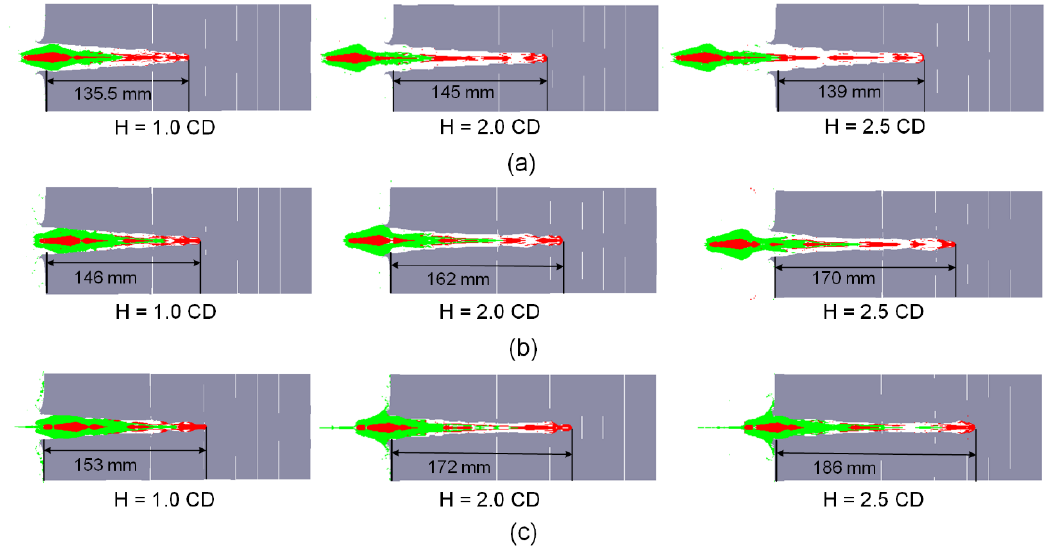
Figure 13. Numerical simulation results of the RM-CJ penetrating steel target. ( a ) b 1 = 3 mm; ( b ) b 1 = 4